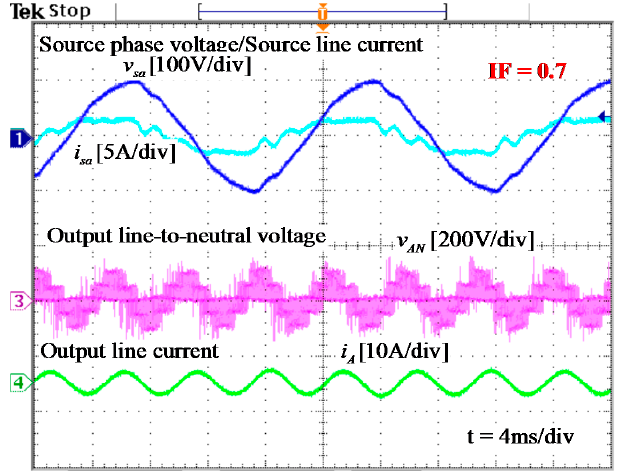
Figure 12. Source phase voltage / source current, output line-to-neutral voltage, and output line current at f o = 200 Hz ( Q ≈ 0.375 ) , q = 0.6 with no compensation.